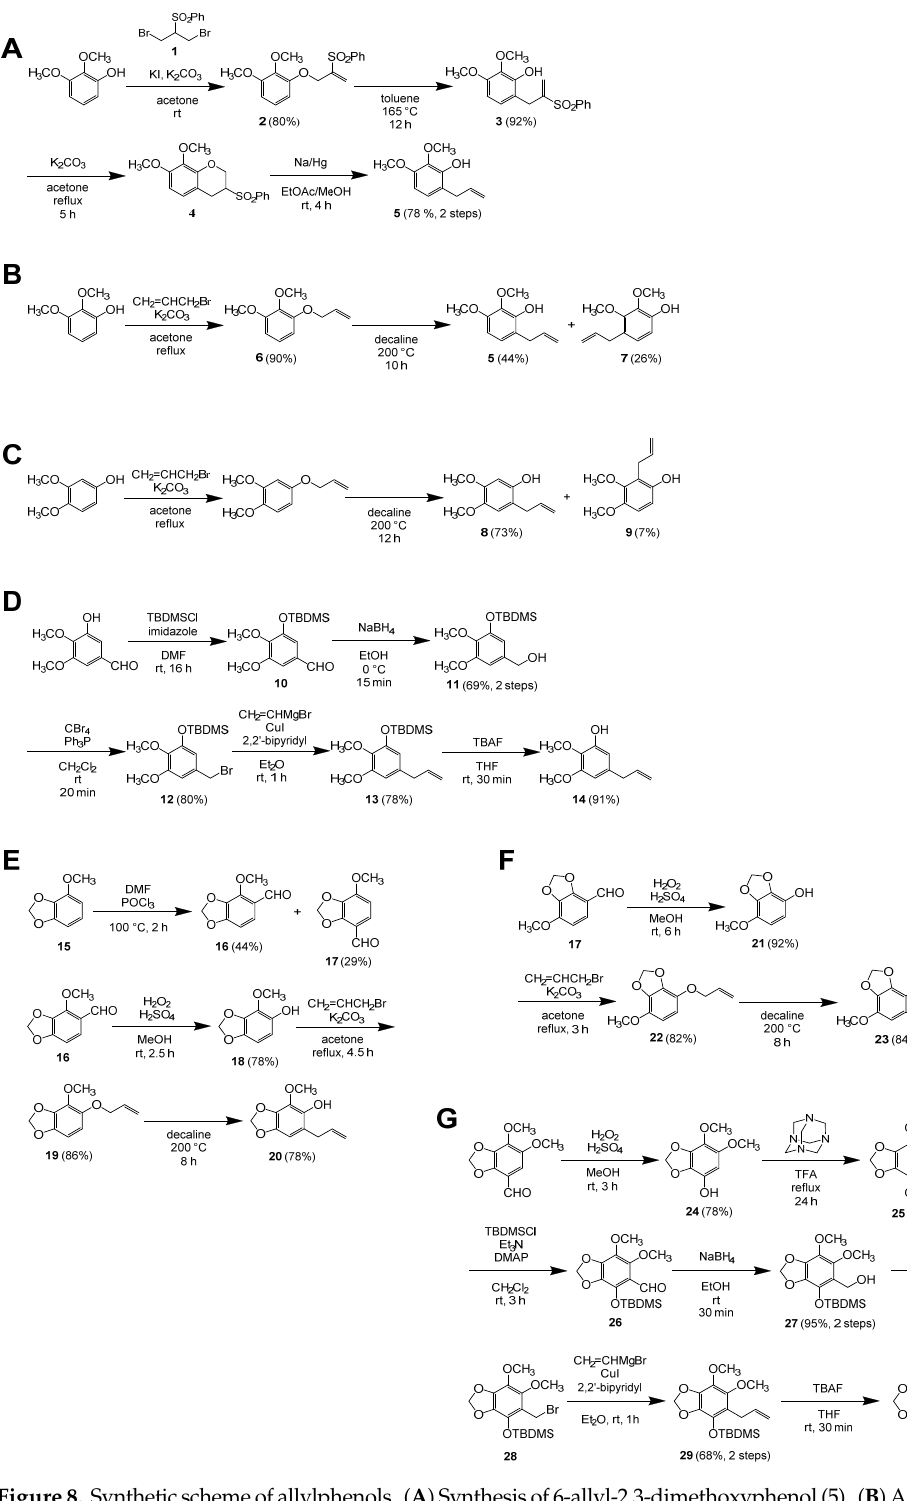
Figure 8. Synthetic scheme of allylphenols. ( A ) Synthesis of 6-allyl-2,3-dimethoxyphenol (5). ( B ) Figure 8. Syntheticschemeofallylphenols. ( A )Synthesisof6-allyl-2,3-dimethoxyphenol(5). ( B )Alternative Alternative synthesis of 6-allyl-2,3-dimethoxyphenol (5). ( C ) Synthesis of synthesis of 6-allyl-2,3-dimethoxyphenol (5). ( C ) Synthesis of 2-allyl-4,5-dimethoxyphenol (8). ( D ) Synthesis 2-allyl-4,5-dimethoxyphenol (8). ( D ) Synthesis of 5-allyl-2,3-dimethoxyphenol (14). ( E ) Synthesis of of 5-allyl-2,3-dimethoxyphenol (14). ( E ) Synthesis of 6-allyl-4-methoxy-1,3-benzodioxol-5-ol (20). 6-allyl-4-methoxy-1,3-benzodioxol-5-ol (20). ( F ) Synthesis of 5-allyl-7-methoxy-1,3-benzodioxol-4-ol ( F ) Synthesis of 5-allyl-7-methoxy-1,3-benzodioxol-4-ol (23). ( G ) Synthesis of 5-allyl-6,7-dimethoxy-1,3- (23). ( G ) Synthesis of 5-allyl-6,7-dimethoxy-1,3-benzodioxol-4-ol (30). benzodioxol-4-ol